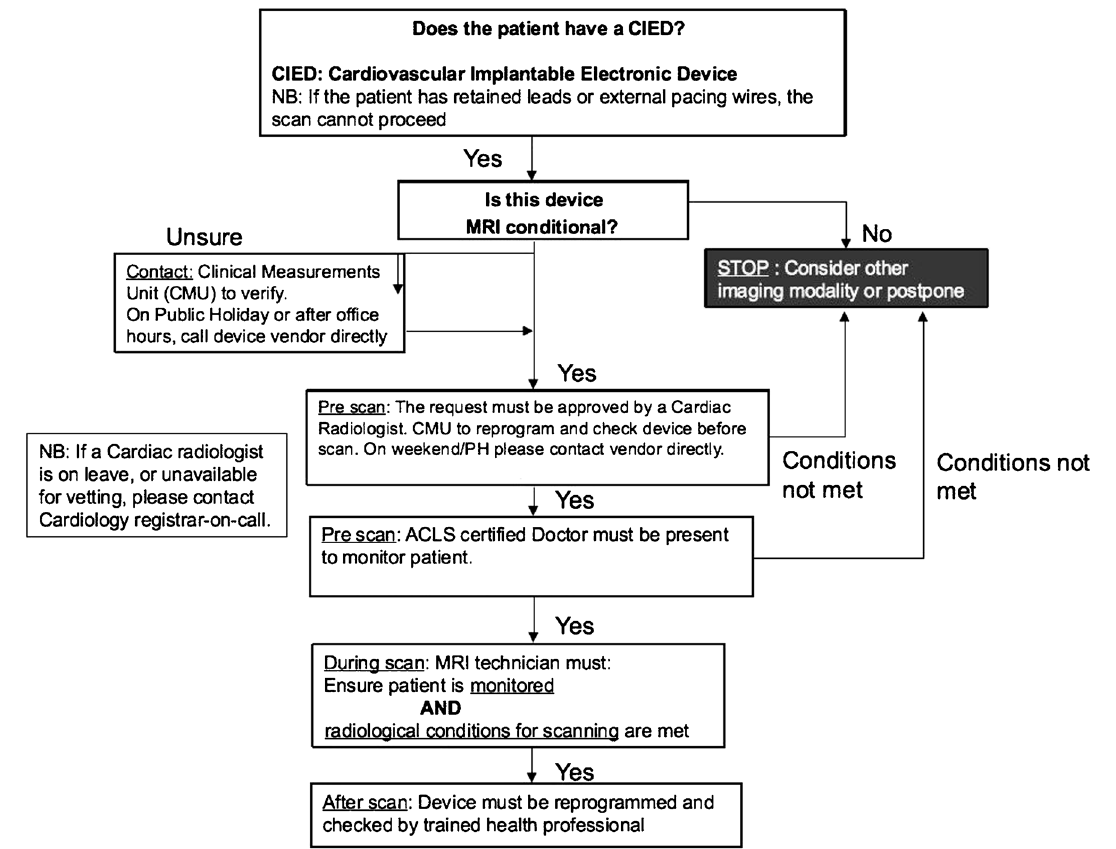
Fig. 16 Algorithm for the MR scanning of patients with CIEDs